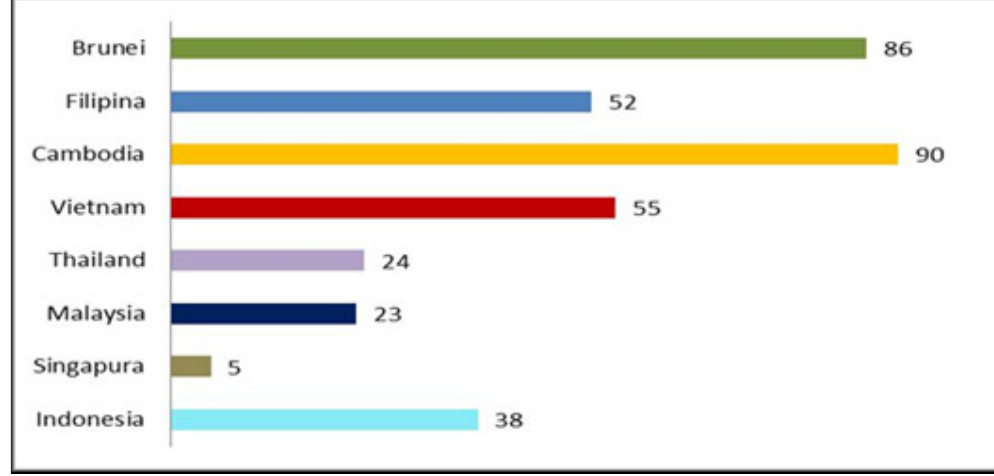
Figure 1: Competitive Industrial Performance of ASEAN Region